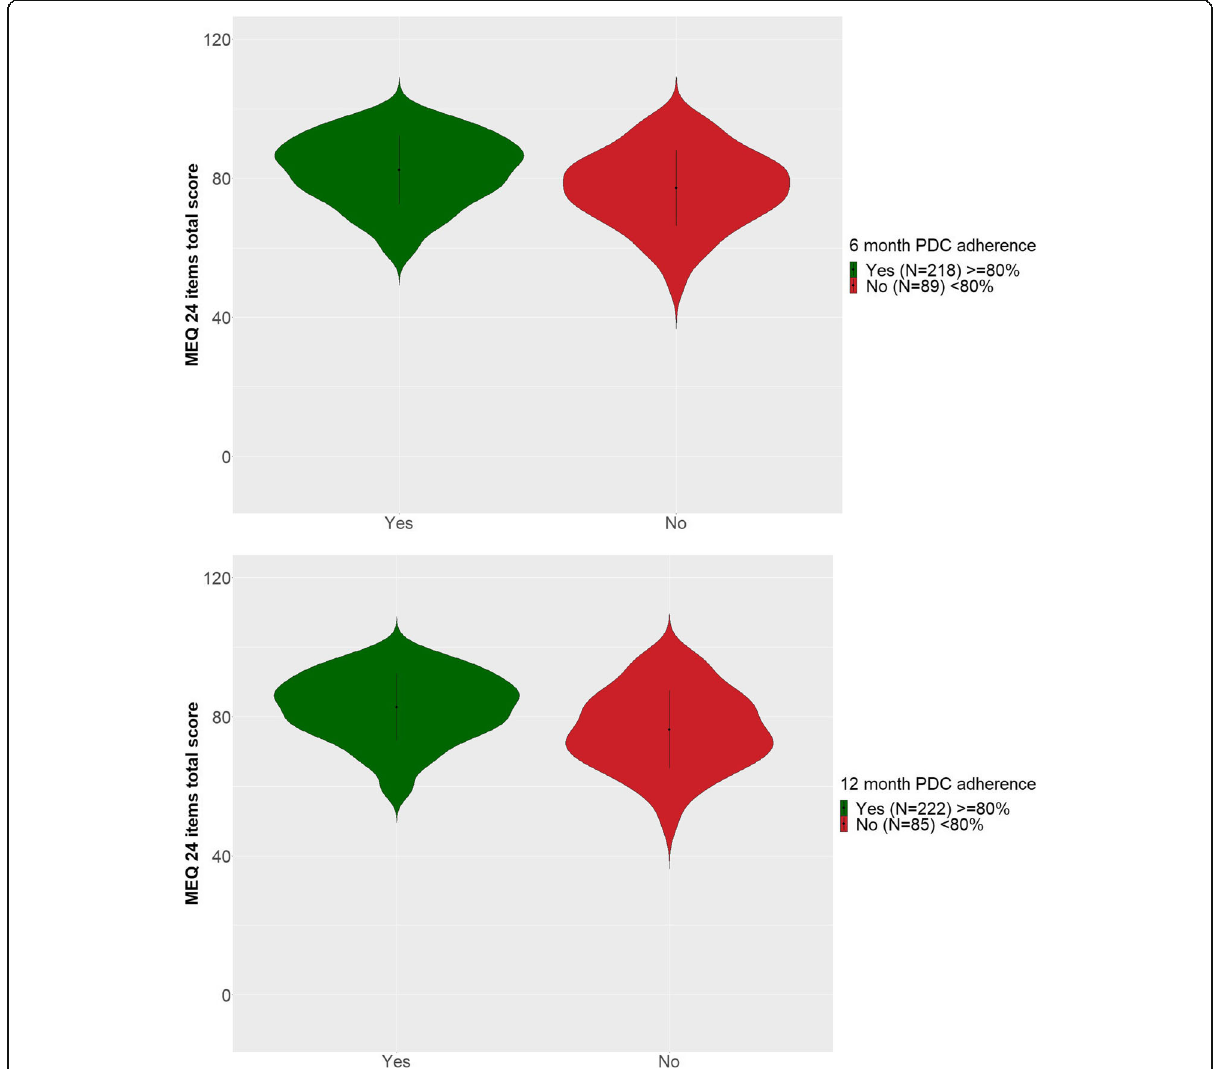
Fig. 3 Known-groups validity – Violin plot showing the Mean, standard deviation and distribution of the MEQ Total Score by a) 6-month PDC and b) 12-month